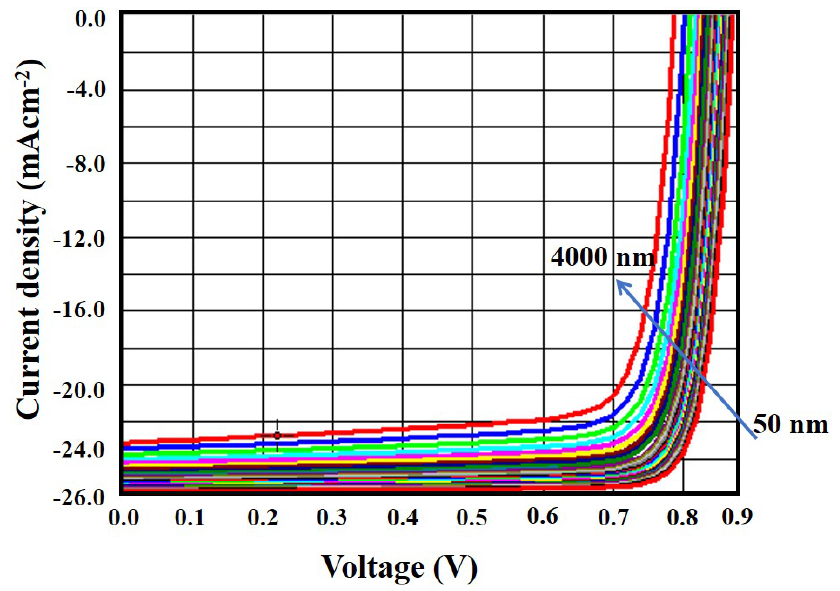
Figure 5. J–V curve with the variation of absorber layer thickness.